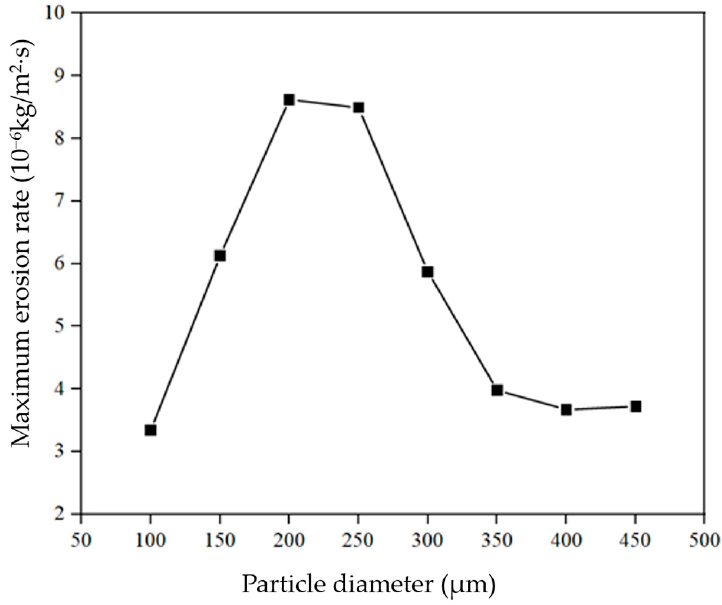
Figure 13. The relationship between maximum erosion rate and particle